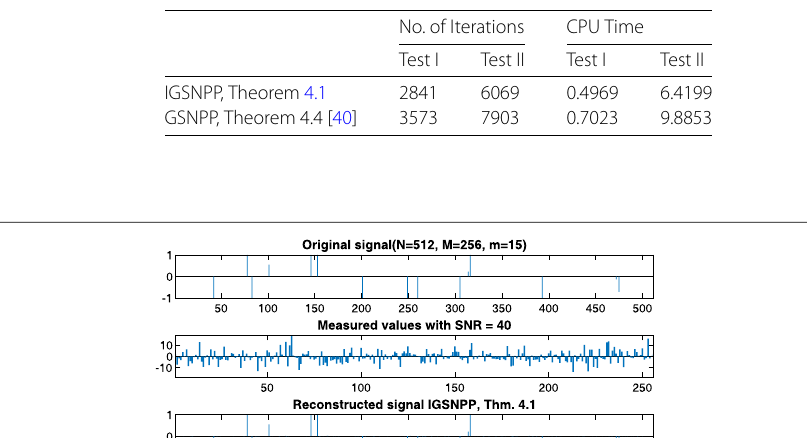
Table 1 Comparison of Theorems 4.1 and 4.4 (Reich et al. [40])